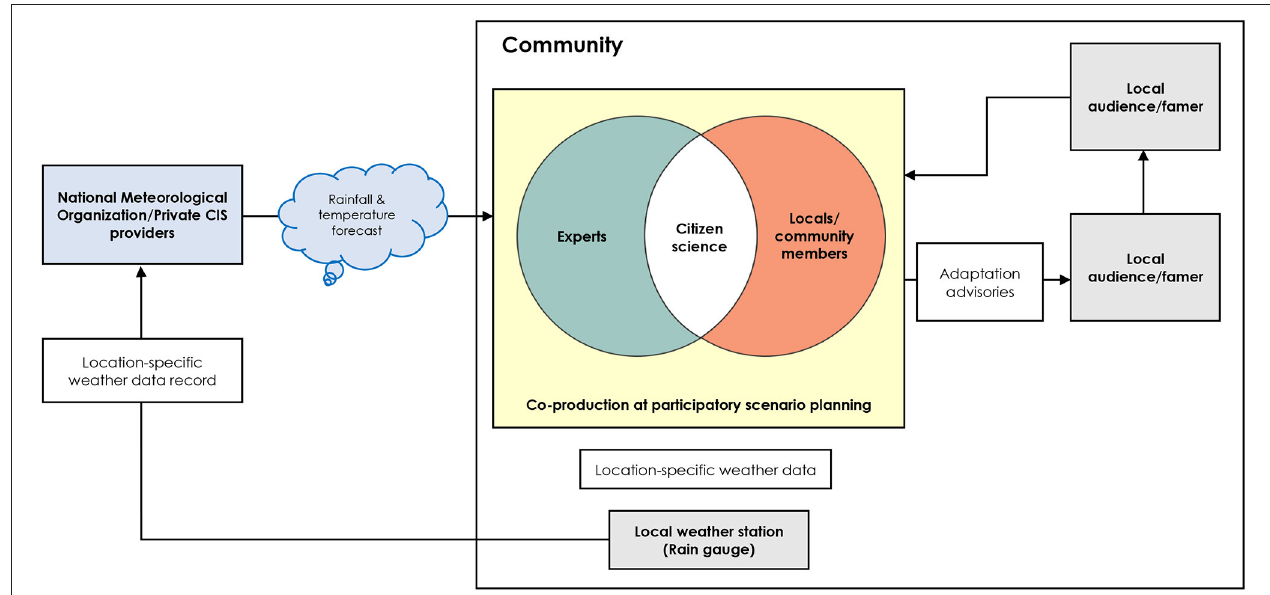
FIGURE 2 | A new climate information co-production and deployment model produced by authors to differentiate the status quo as in Figure 1 from what is proposed.